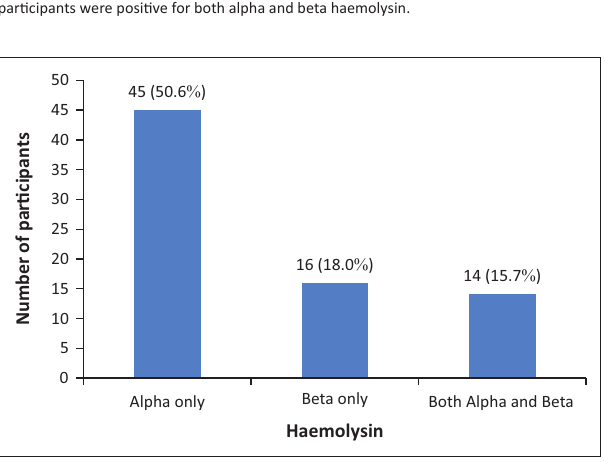
FIGURE 3: Prevalence of significant titres of alpha and beta haemolysins among blood group O donors at the RHBBB, Cameroon, June 2020 – September